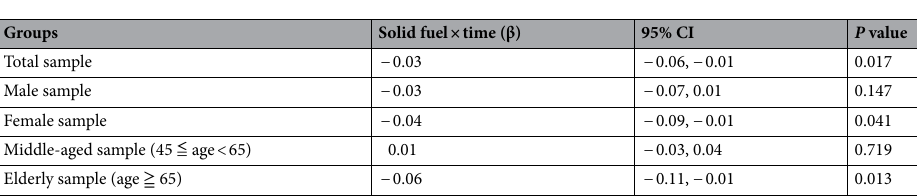
Table 4. Association between solid fuel use and the rate of cognitive decline. In liner mixed models of different gender subgroups, we adjusted for cooking fuel use, time, cooking fuel use × time, age, residential area, marital status, education, smoking status, drinking status, sleep time, depressive symptom, chronic diseases and self-rated health. In age subgroups, we adjusted for cooking fuel use, time, cooking fuel use × time, gender, residential area, marital status, education, smoking status, drinking status, sleep time, depressive symptom, chronic diseases and self-rated